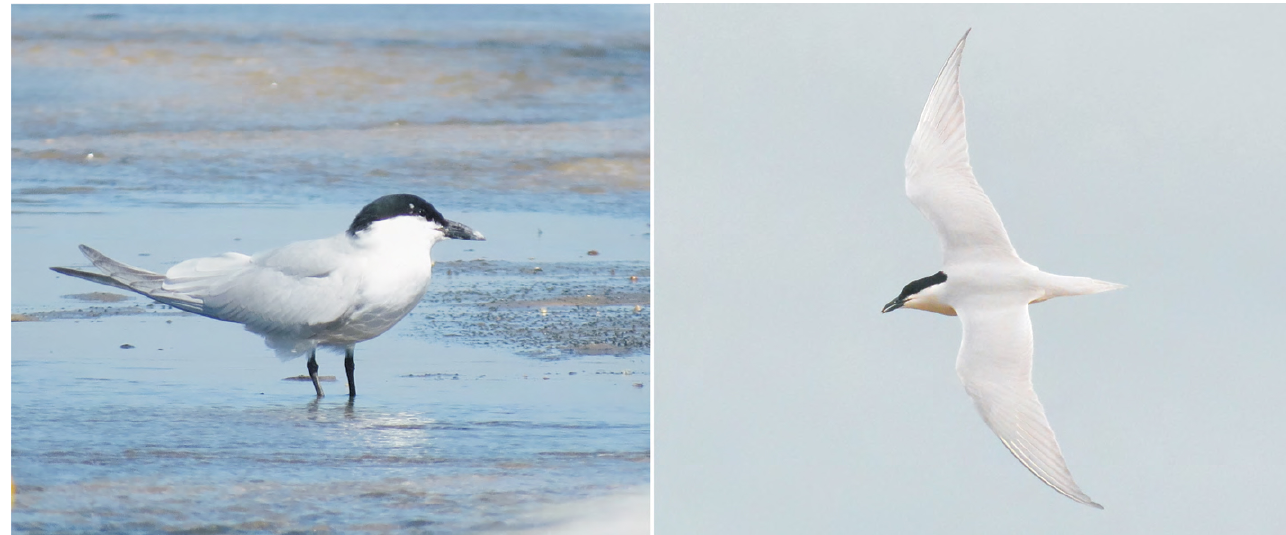
Figure 1. Adult Gull-billed Tern, Gelochelidon nilotica , with breeding plumage, recorded in August-September 2014 (left) and September 2015 (right) at Sepetiba beach, Rio de Janeiro municipality, southeastern Brazil. Photographs: Roberta Guido (left) and Robson Czaban